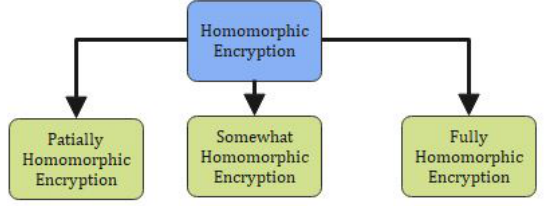
Figure 1. Classification of Homomorphic